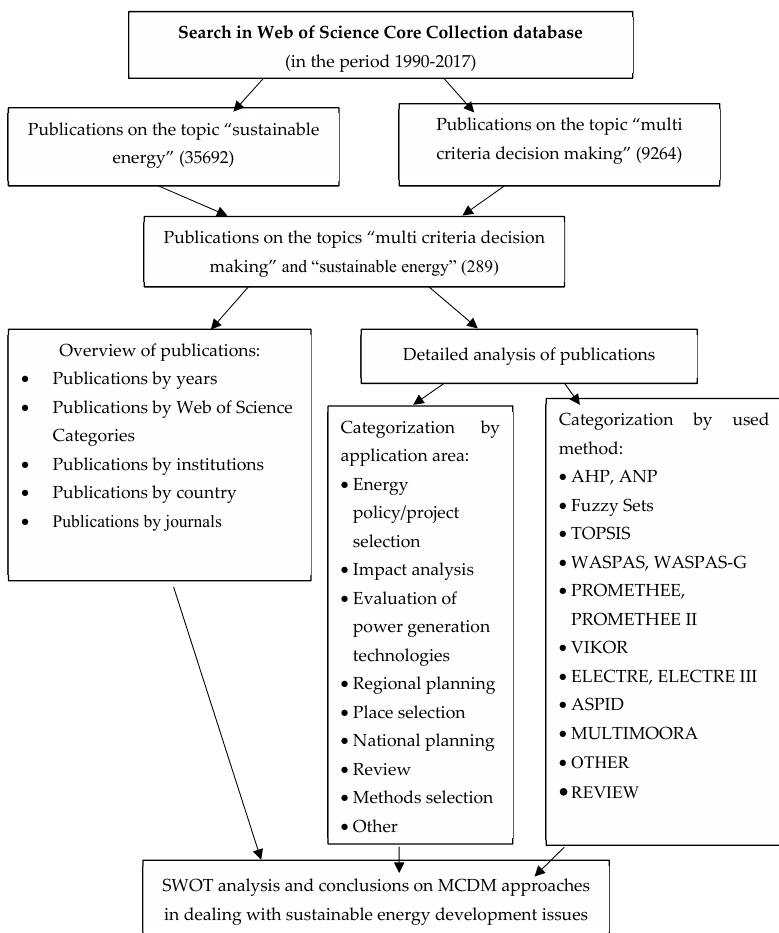
Figure 2. The logical scheme of the research.